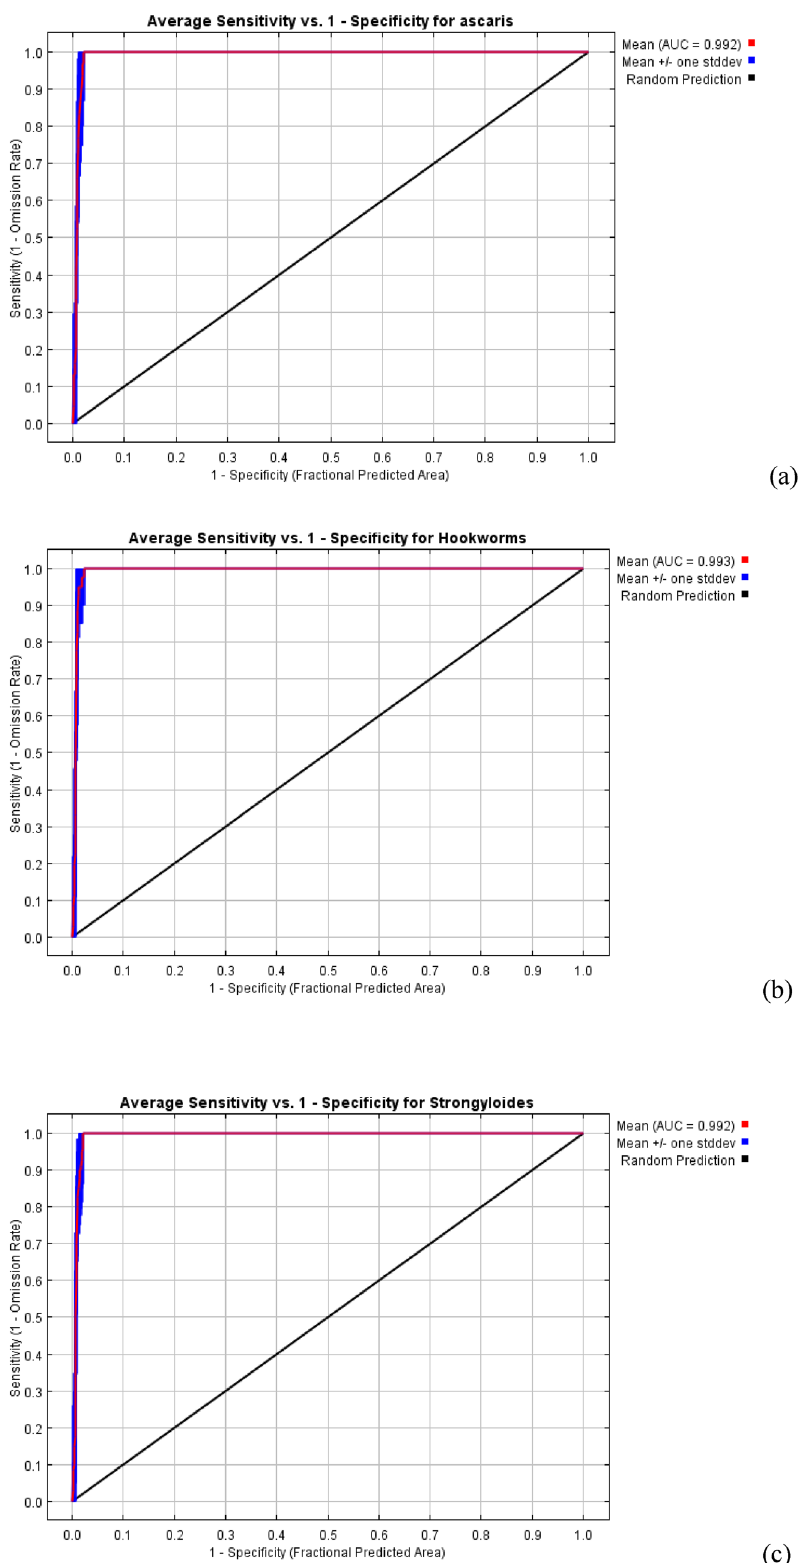
Figure 4. Receiver Operating Characteristics (ROC) curves for a A. lumbricoides b Hookworms and c S. stercoralis . Red line indicates the mean value for 10 MaxEnt replicate runs and blue indicates the standard